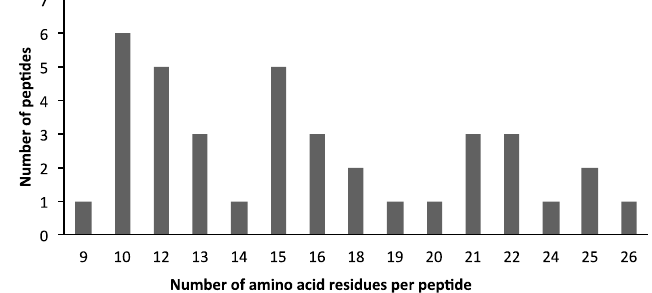
Figure 3. Size distribution of AEP peptides according to the number of amino acid residues per